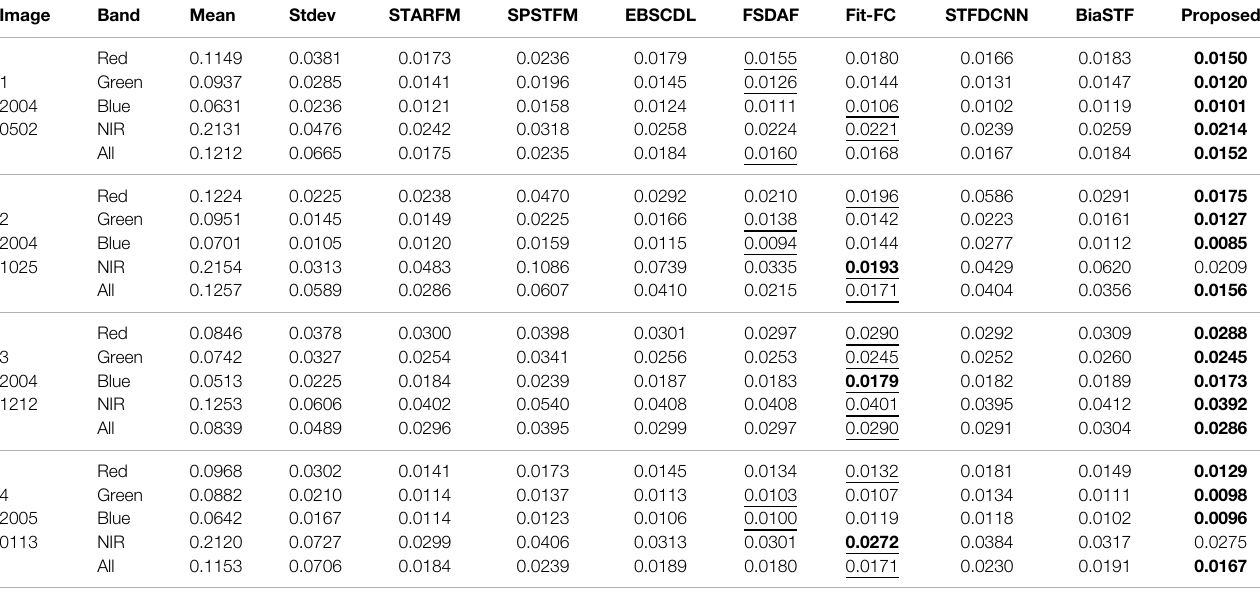
TABLE 2 | RMSE evaluation of radiometric error for the LGC dataset. Image